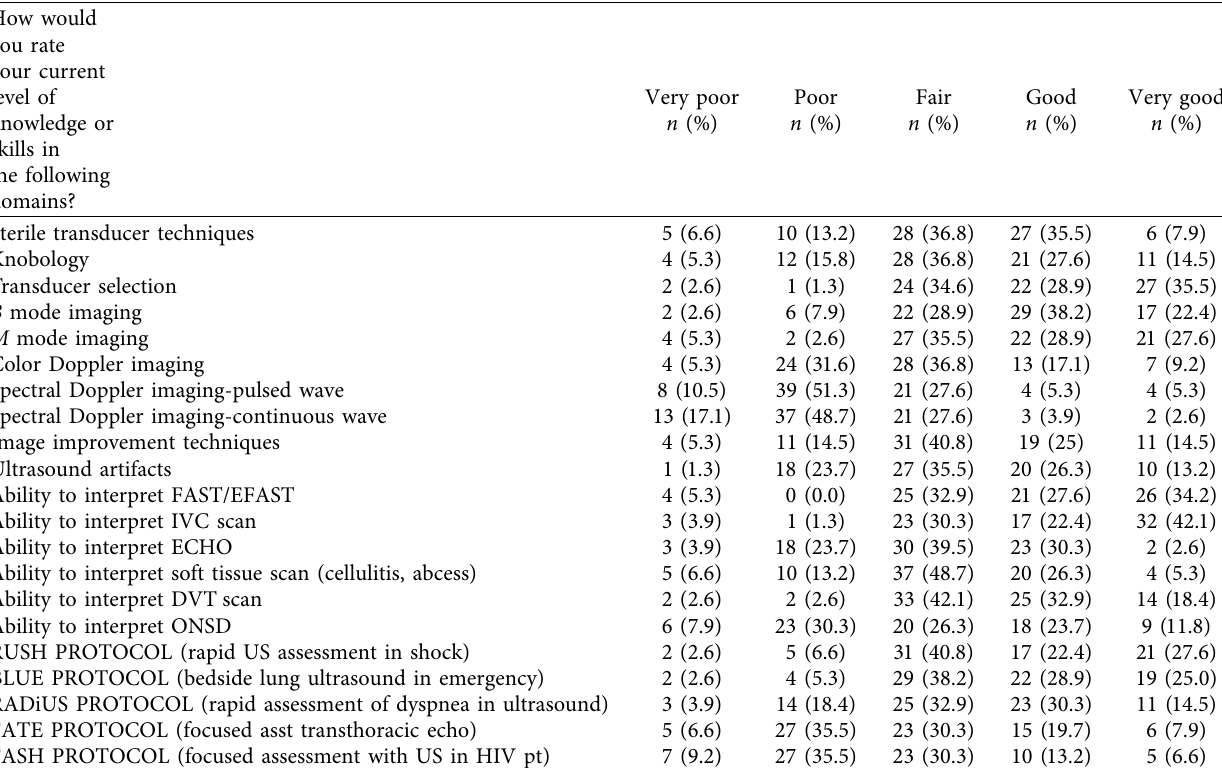
Table 2: Current level of knowledge or skills related to POCUS of senior emergency medicine and critical care residents in SPHMMC